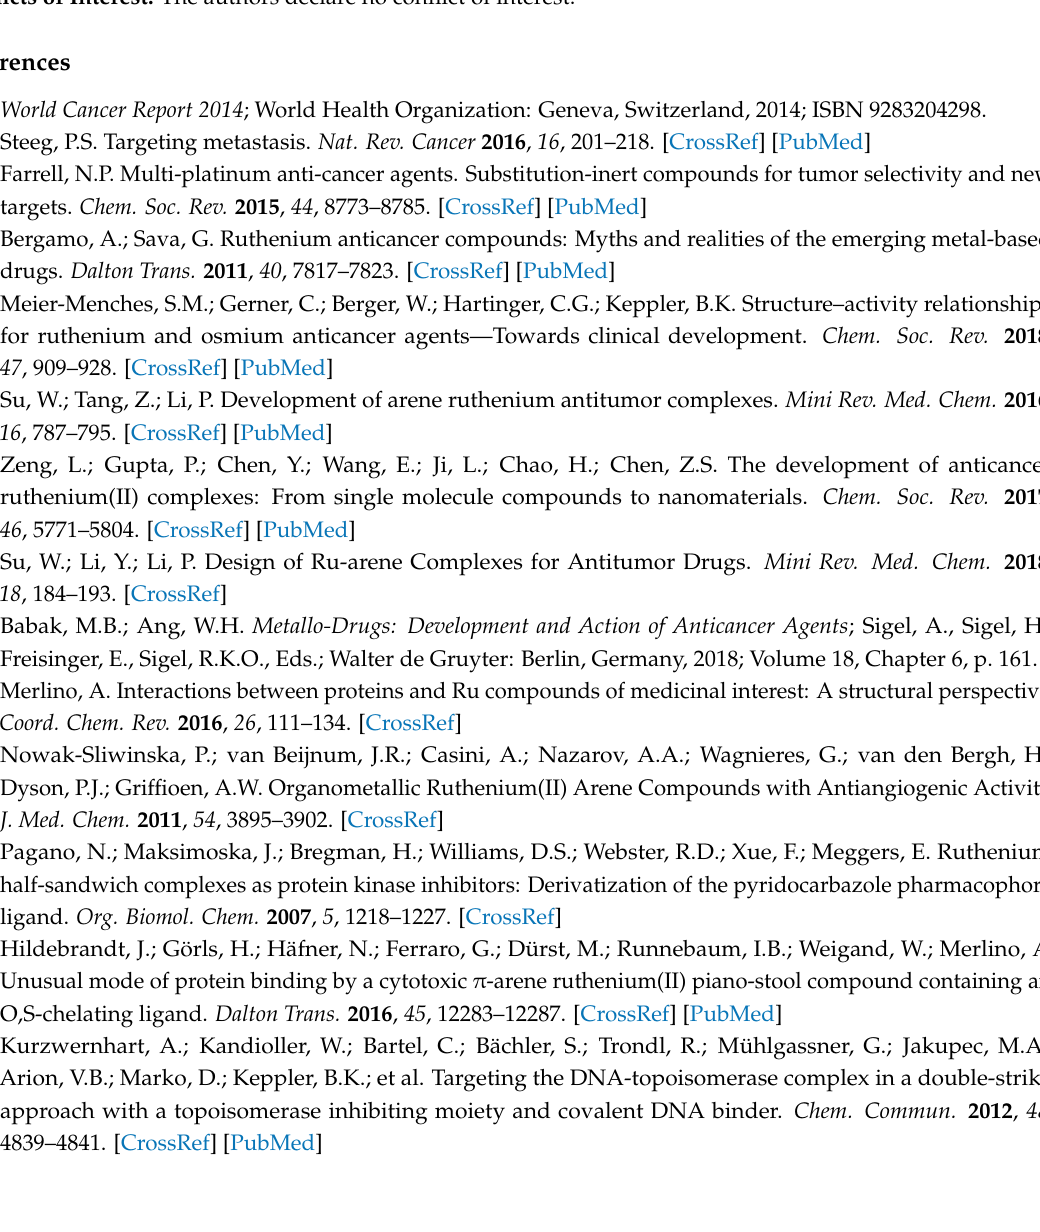
Figure S1: Spectrofluorometric titration spectra of HSA with ruthenium compounds 2 – 4 . Figure S2: 1 H NMR spectrum of guanosine and complex 3 at different times (only resonances of H8, NH and NH2 are assignments). Figure S3: Hoechst 33258 (H33258) displacement assay for metal complexes 2 – 4 . Figure S4: 31 P{ 1 H} NMR spectrum in the mixture 70:30 DMSO: Culture medium (DMEM) of complex 3 at different